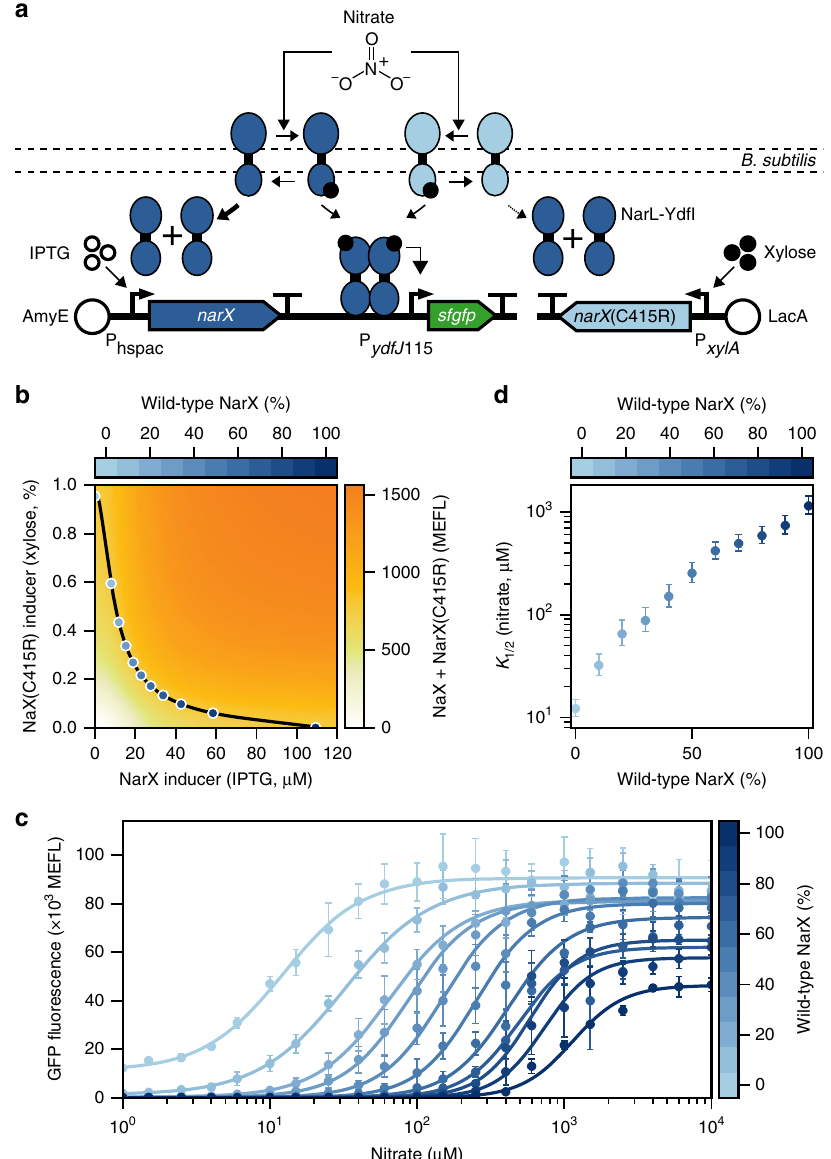
Fig. 3 Detection threshold decreases continuously with phosphatase activity. a Cartoon of the genetic system engineered for the iso-SK experiment. Both NarX and NarX(C415R) are expressed under inducible promoters in the same cell. Both wild-type and mutant SKs have kinase and phosphatase activity on a constitutively expressed NarL-YdfI. b IPTG and xylose are used to express different levels of NarX and NarX(C415R) resulting in different total SK concentrations (Supplementary Figure 6). We selected induction levels that result in 775 MEFL (Methods) of total SK expression (black line), while evenly varying the percentage of NarX compared to total SK levels between 0 and 100% (blue points). Requisite inducer concentrations were calculated by inverting the Hill fi ts ½ inducer (cid:2) ¼ in (Supplementary Fig. 6). c Nitrate transfer functions for the iso-SK strain when induced with IPTG and xylose to the 11 different percentages of wild-type NarX from ( b ). Points represent the mean and error bars the standard error of the mean (SEM) of experiments on three separate days. d The relationship between the percent NarX and the K 1/2 of the Hill function fi ts in ( c ). Points represent the K 1/2 values and error bars the 95% con fi dence intervals of the best fi